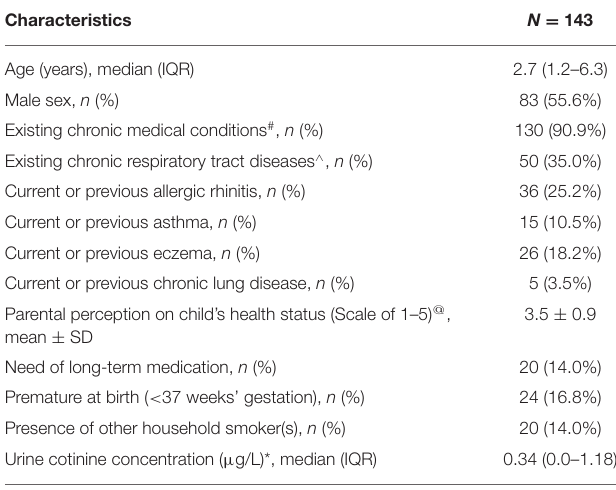
TABLE 2 | Demographic and clinical characteristics of the pediatric patients ( N =